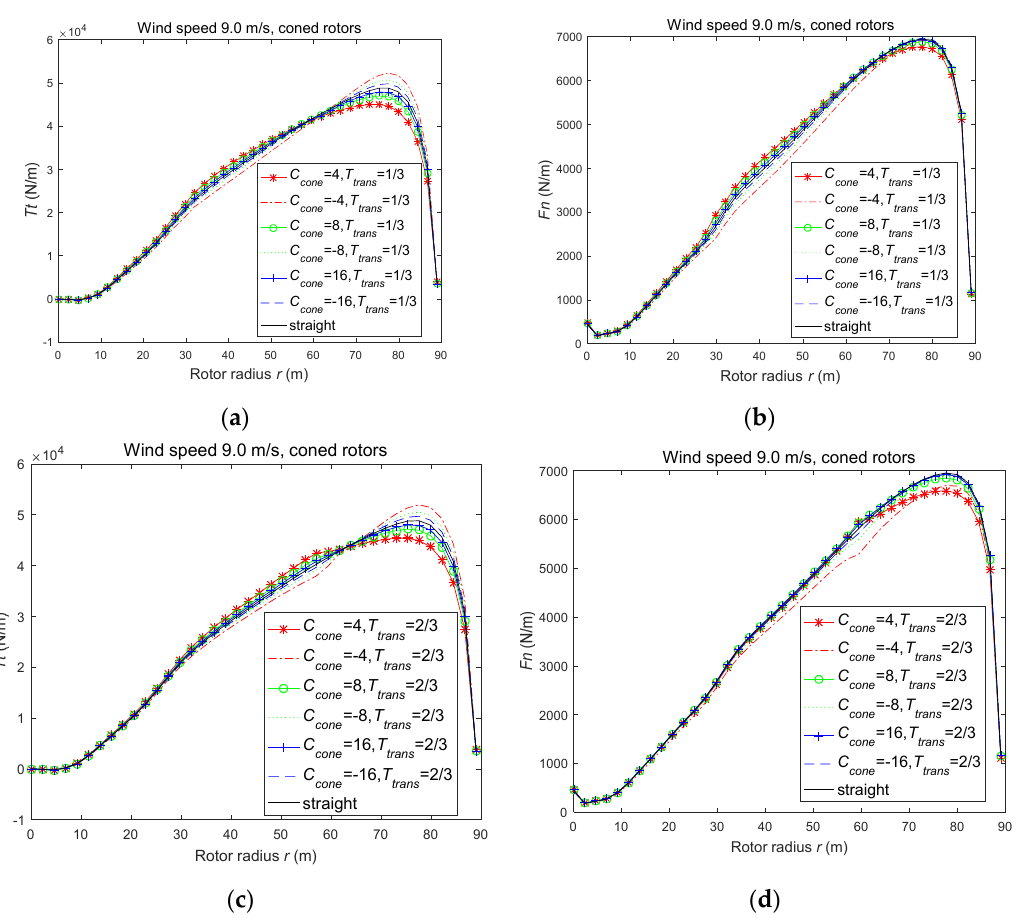
Figure 7. Comparison of spanwise force distributions at wind speed 9m/s: ( a ) T trans = 1/3, torque force;